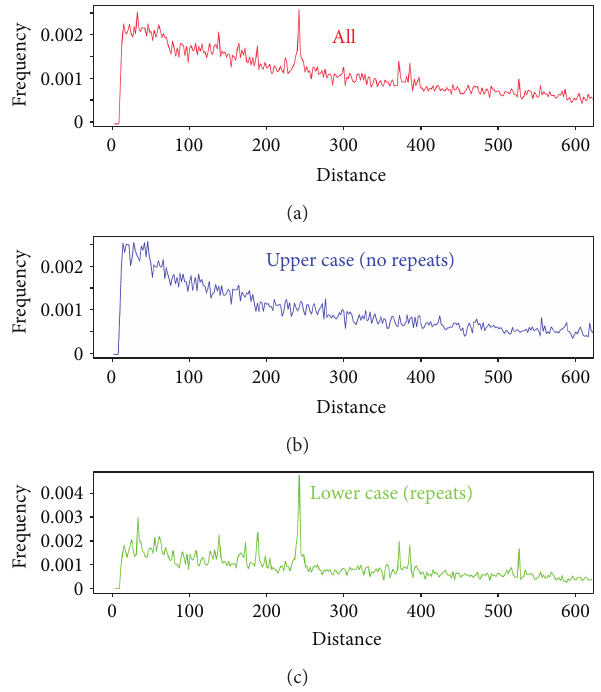
Figure 4: (a) Histogram of the spacing of the decamer YYYYYRRRRR in chromosome 21 of Homo sapiens (b) Histogram of the intact chromosome without repetitive elements; (c) Histogram of repetitive elements